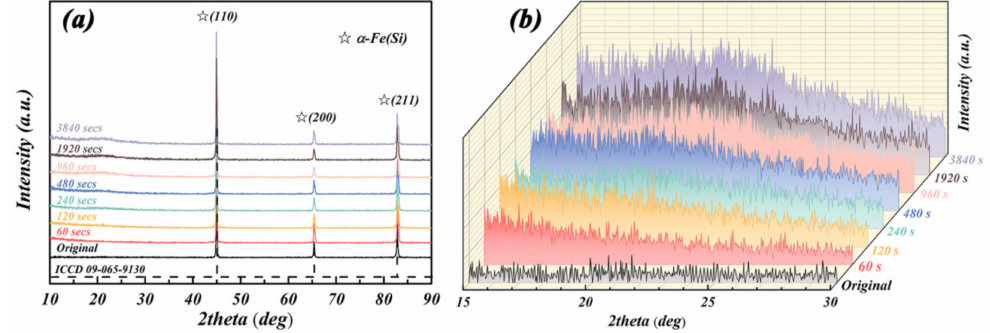
Figure 1. ( a ) X-ray diffractometer (XRD) patterns and ( b ) partially enlarged XRD patterns of the original